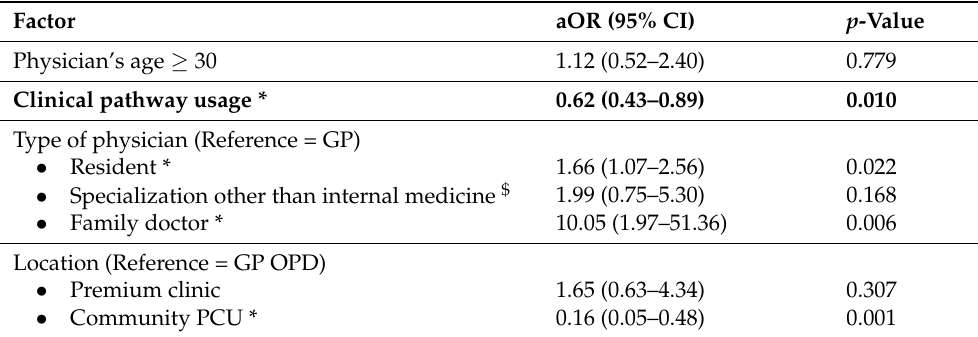
Table 4. Factors associated with antibiotic prescription (multivariate analysis) when adjusted for physician’s age, location, specialization, and clinical pathway